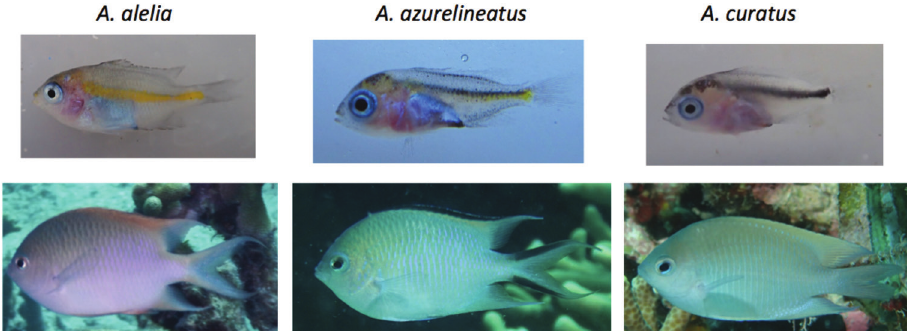
Figure 4. Altrichthys species. Juvenile and adult Altrichthys are shown from left to right: A. alelia , A. azurelineatus , and A. curatus . Note the prominent yellow line in the juvenile A. alelia , and the lack of black margins in the dorsal and caudal fins in the adult. Table 2. Results of RAD sequencing in three species. Results are based on 8383 variable SNPs for 5 sequenced individuals (2 A. alelia , 1 A. azurelineatus , 2 A. curatus ). Figures refer to the number of SNPs and their percentage (over 8383 total